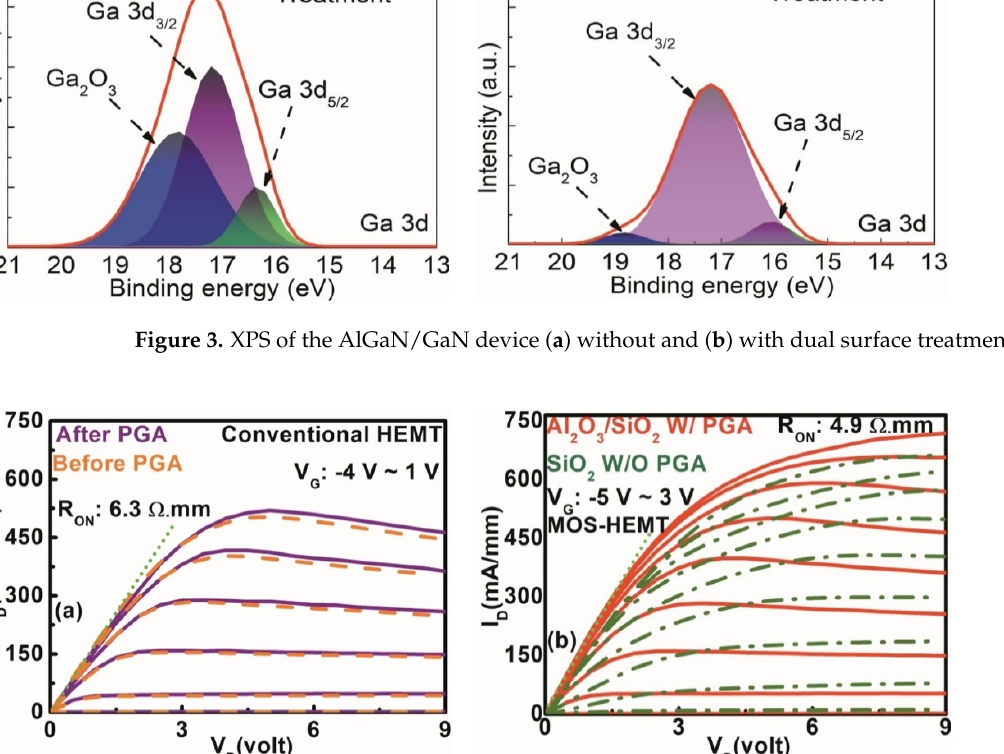
Figure 4. I D –V D characteristics of ( a ) conventional HEMT with and without gate annealing and ( b ) Al 2 O 3 /SiO 2 MOS–HEMT with and without gate annealing treatment and SiO 2 MOS–HEMT without PGA treatment.